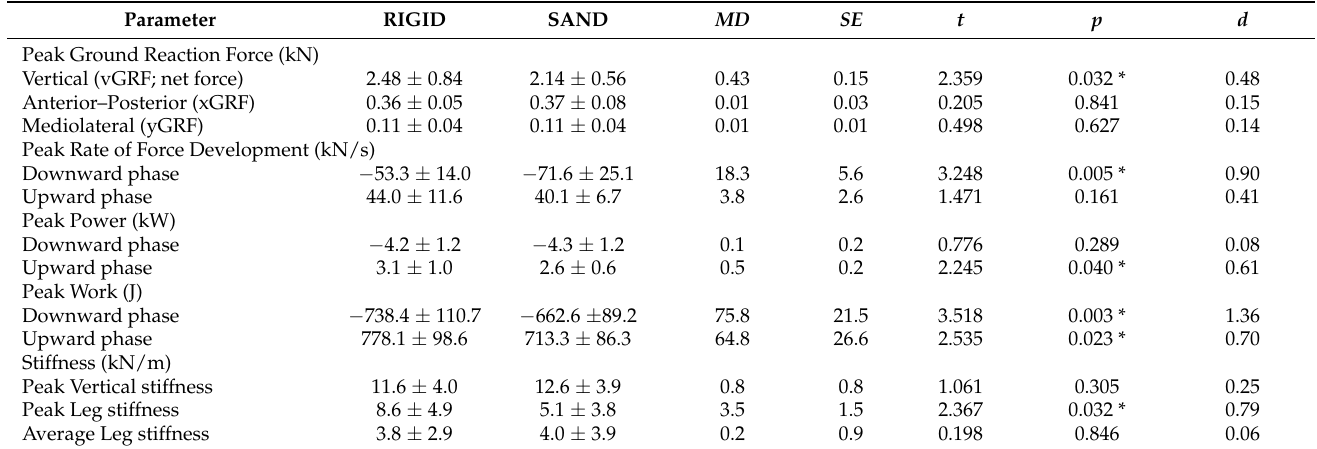
Table 2. Means ± standard deviations of the comparison for the kinetic parameters of the drop jumps on RIGID and SAND surface ( n = 16).